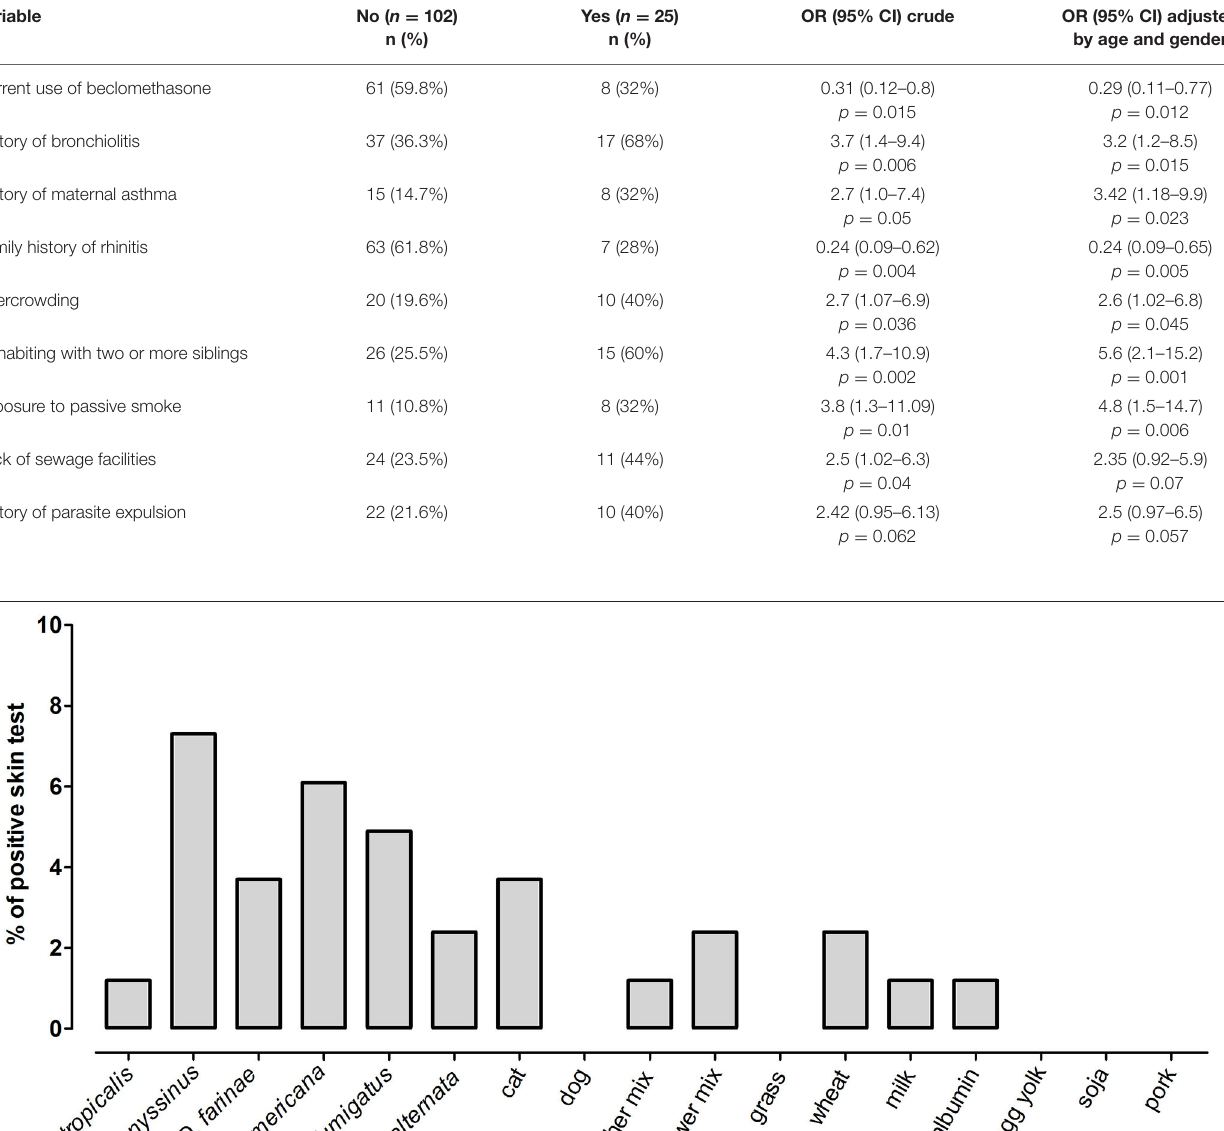
TABLE 5 | Factors associated with ICU admission due to wheezing ( n = 127). Variable OR (95% CI) adjusted